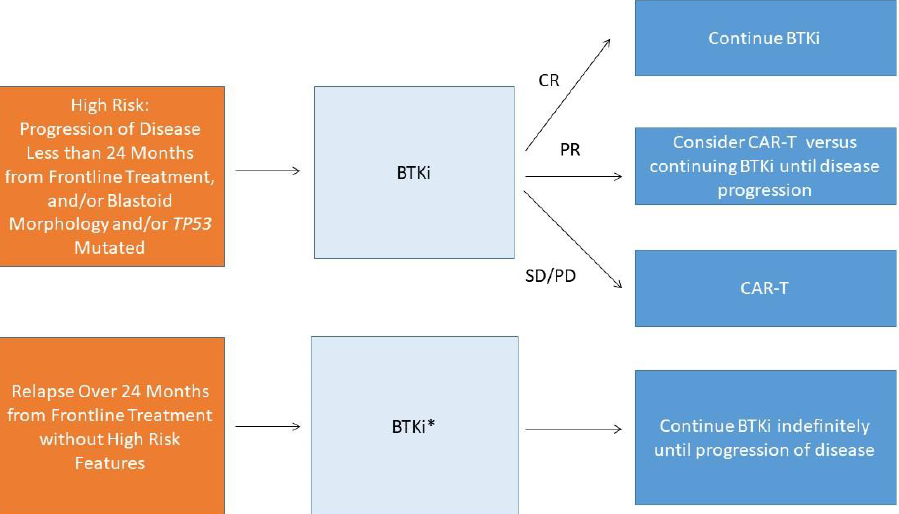
Figure 1. Authors’ Approach to Management of Mantle Cell Lymphoma at First Relapse. BTKi—acalabrutinib, ibrutinib, or